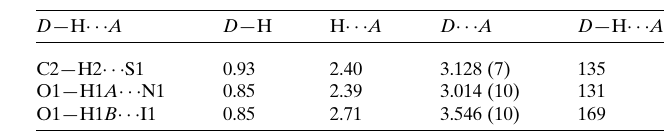
Table 1 Hydrogen-bond geometry (A˚ , (cid:4) ).